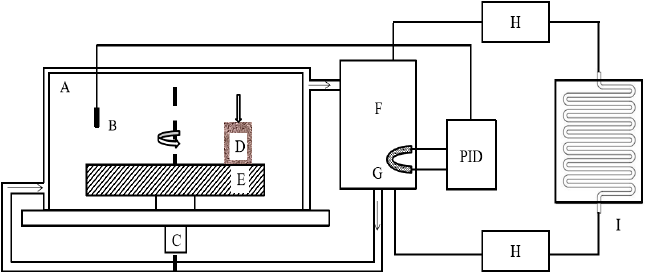
Figure 3. Schematic diagram of the experimental setup: (A) temperature-controlled climate chamber; (B) sensor; (C) base; (D) pin specimen; (E) disc specimen; (F) alcohol tank; (G) red heating plate; (H) transmission line; (I) condenser.